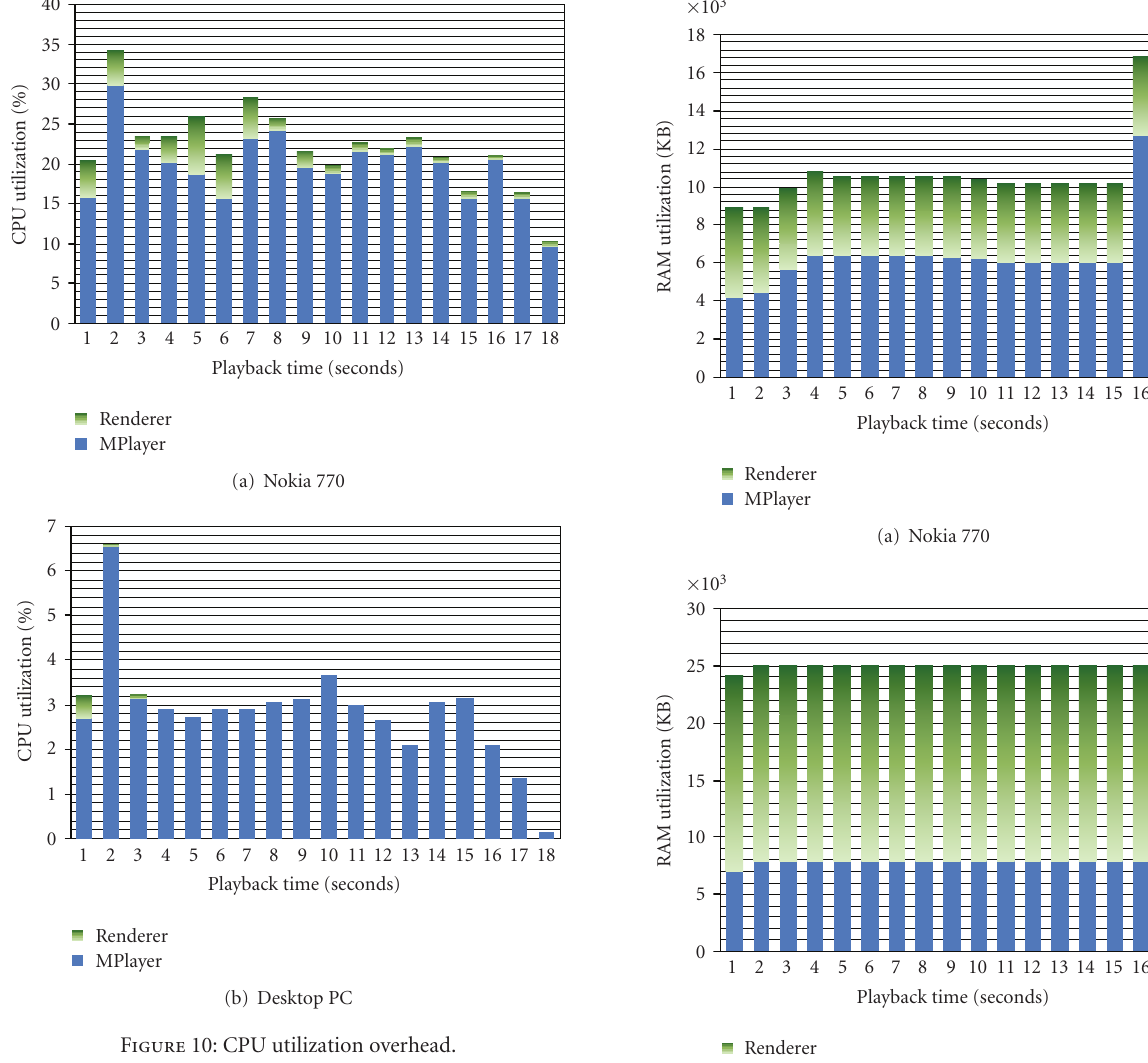
Figure 10: CPU utilization overhead.